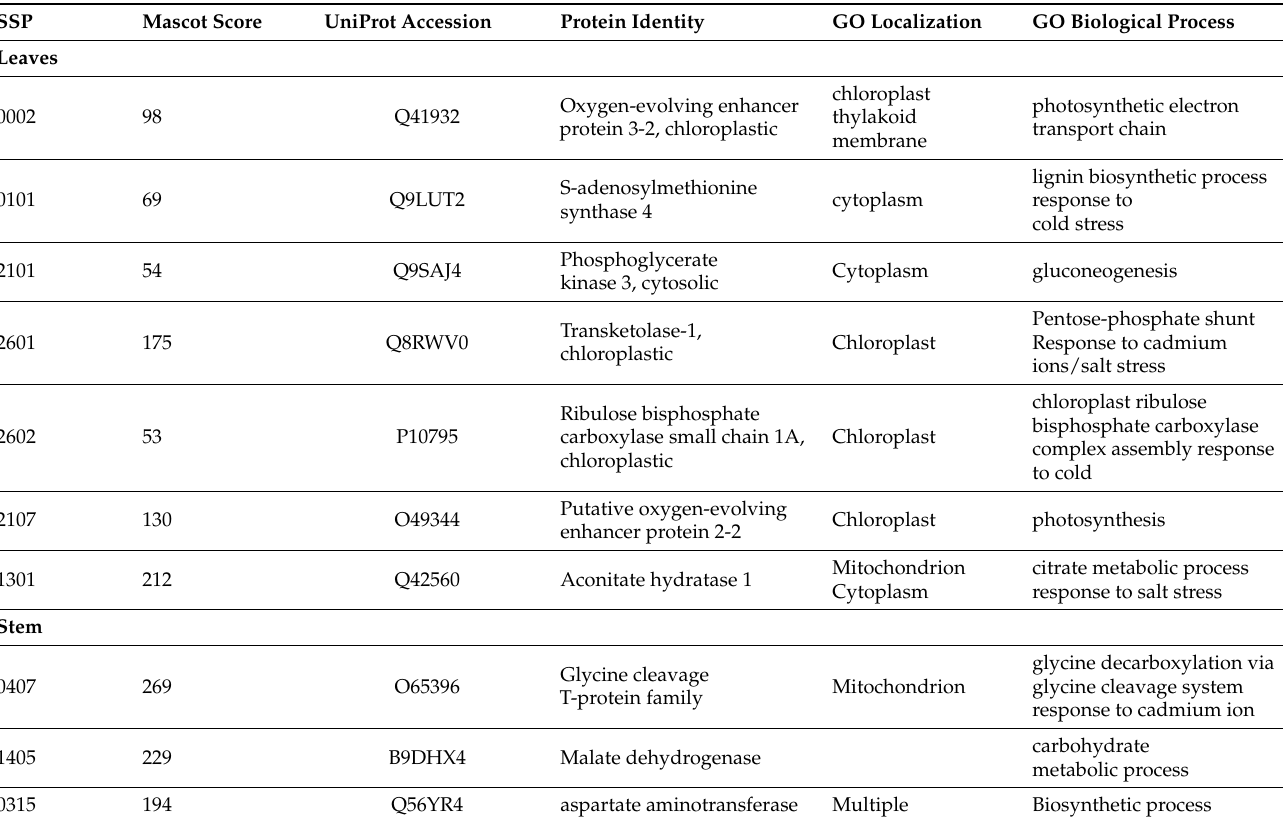
Figure 3. Differentially regulated protein spots, shown as SSP numbers, assigned by PDQuest with 2.5-fold difference in leaves ( a ) and stem ( b ) of Cuscuta australis —parasitized Arabidopsis thaliana . Table 2. MS/MS identified protein spots, up-regulated in leaves and stem of Cuscuta australis — parasitized Arabidopsis thaliana . SSP is the standard spot